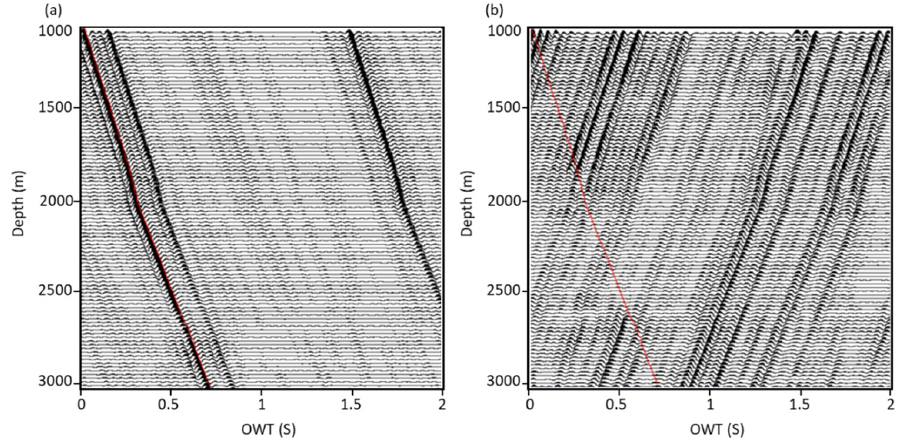
Figure 11. The separated ( a ) downgoing and ( b ) upgoing wavefield. The red line shows the P-wave downgoing primary trend in Figure 9.